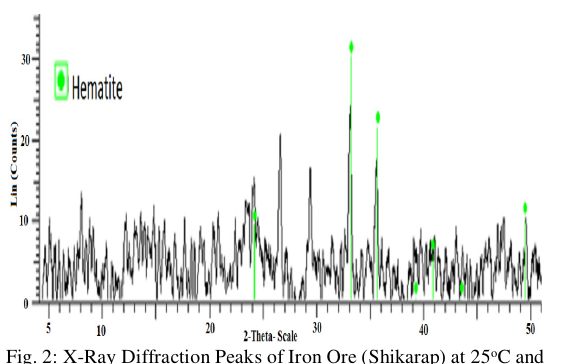
Fig. 2: X-Ray Diffraction Peaks of Iron Ore (Shikarap) at 25 o C and Sample Weight analyzed 1g